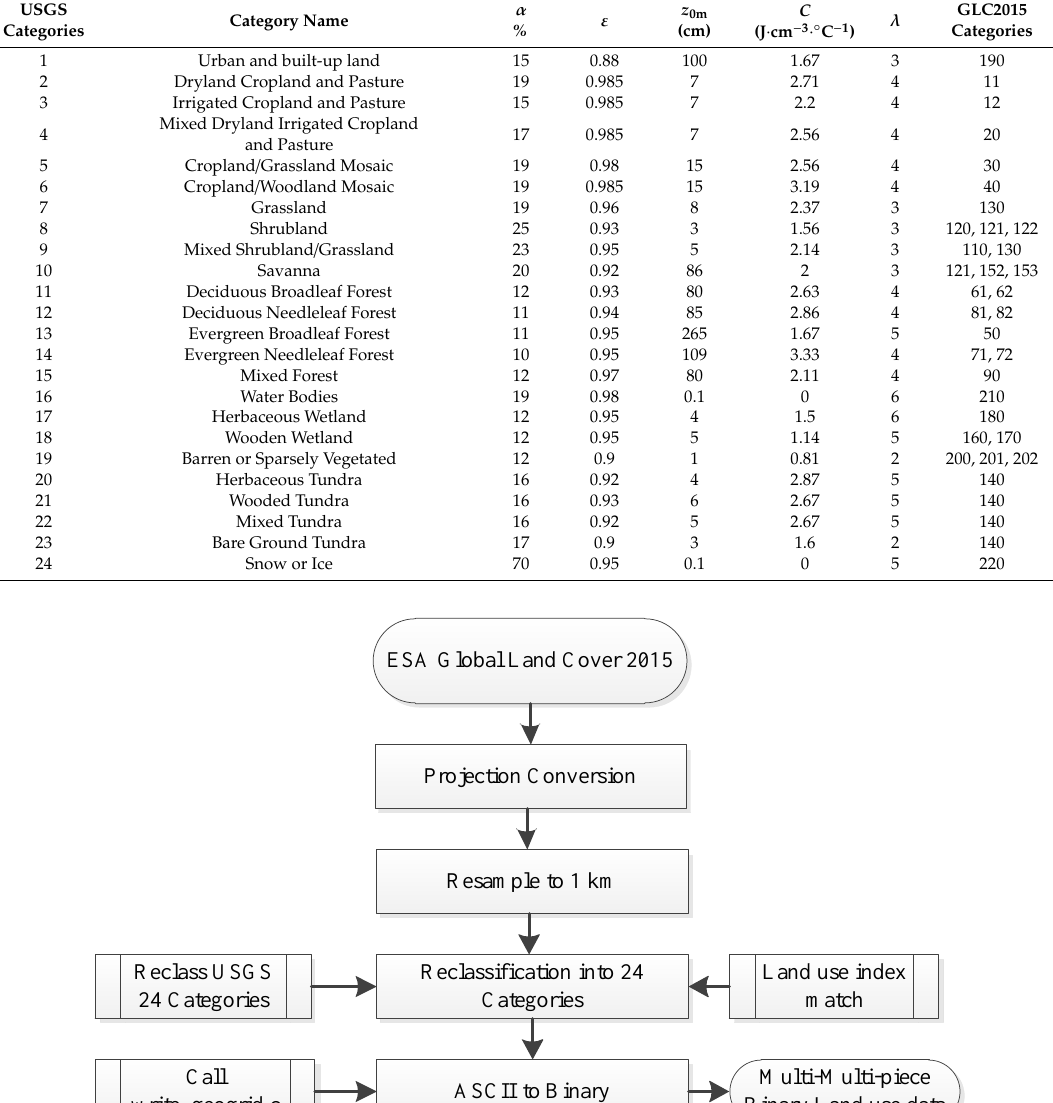
Table 1. Global Land Cover (GLC2015) and United States Geological Survey (USGS) land-use data code conversion table.